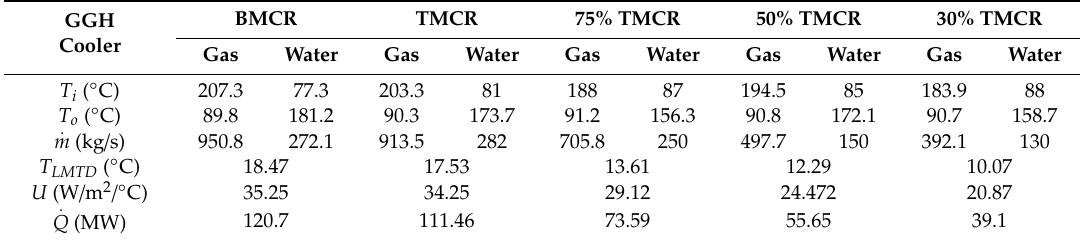
Table 5. New operating conditions for the GGH cooler in the new process based on the load conditions. GGH Cooler